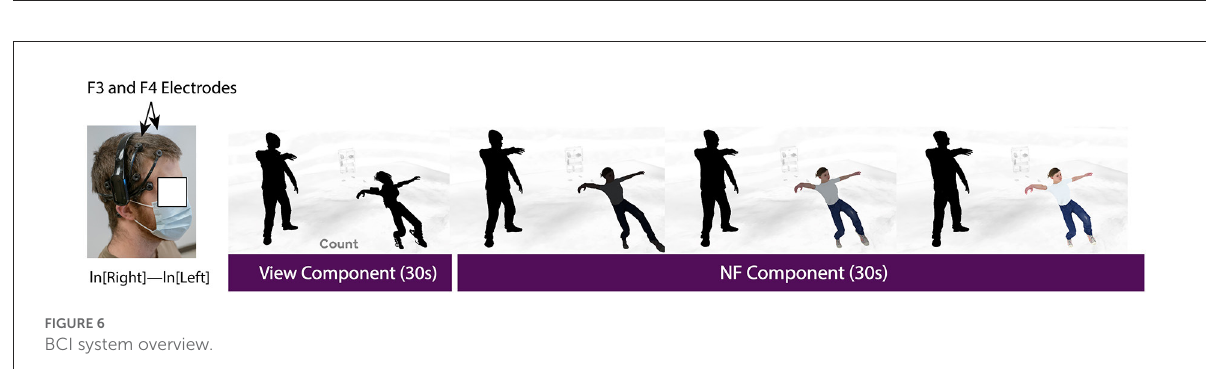
FIGURE6 BCI system